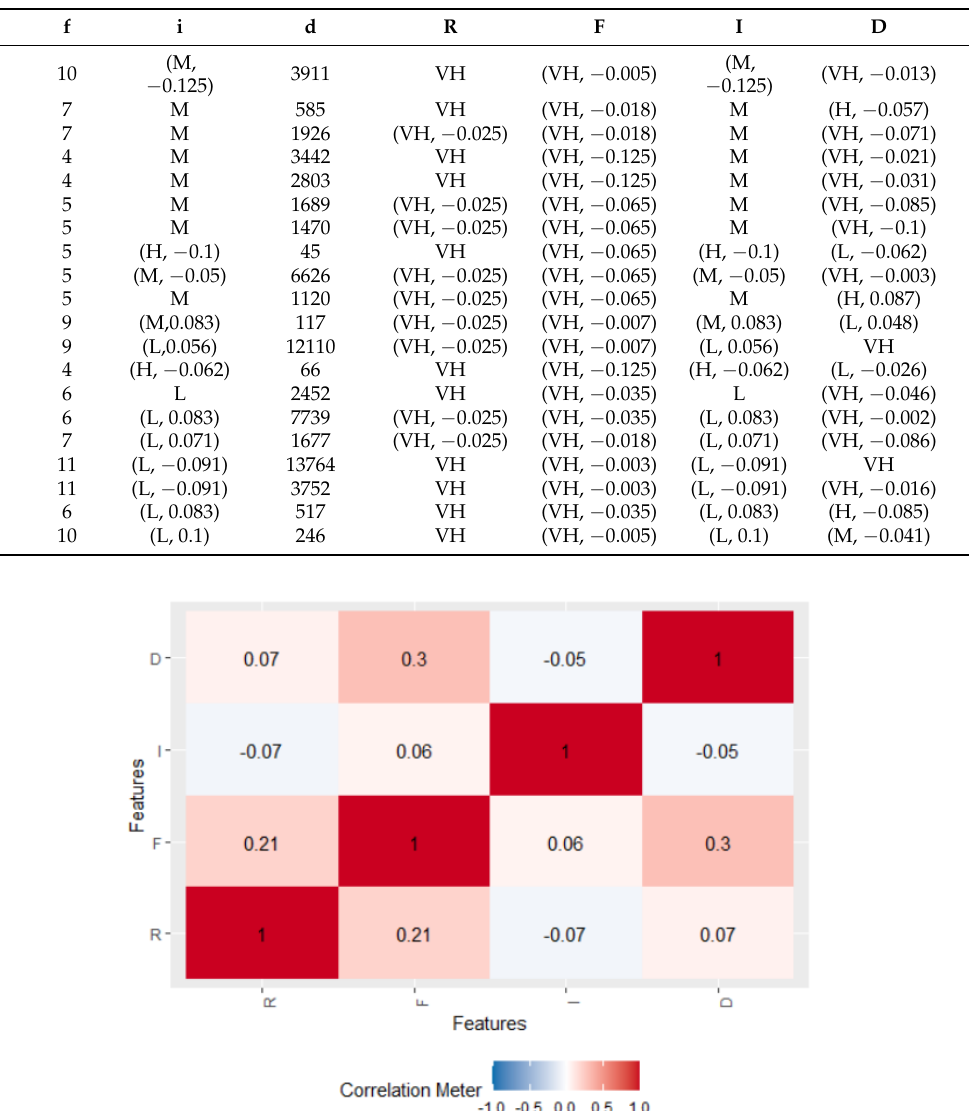
Table 10. Number of Clusters Proposed by the Different Indices.